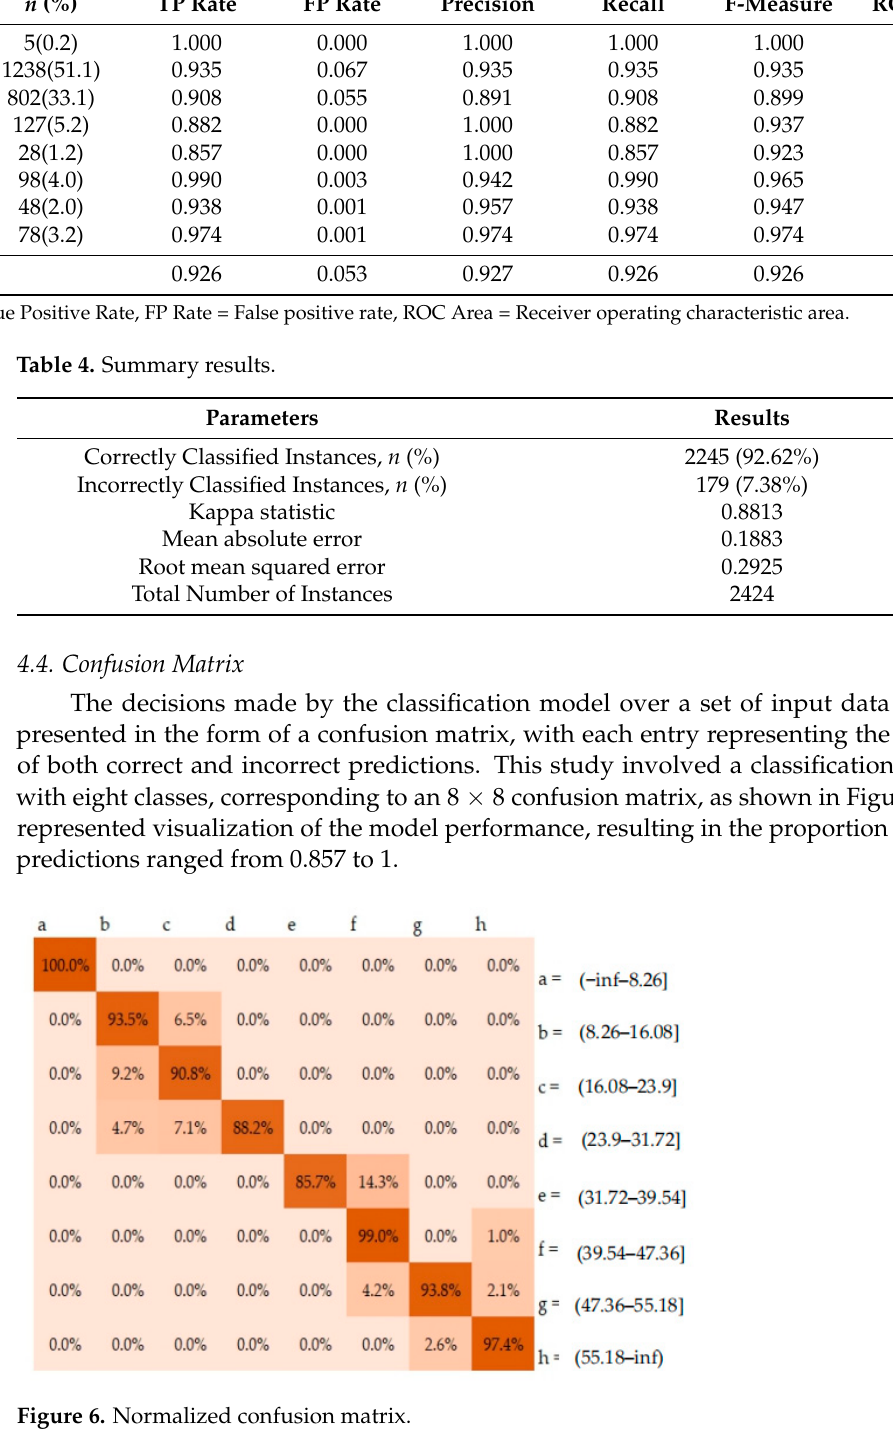
Figure 6. Normalized confusion